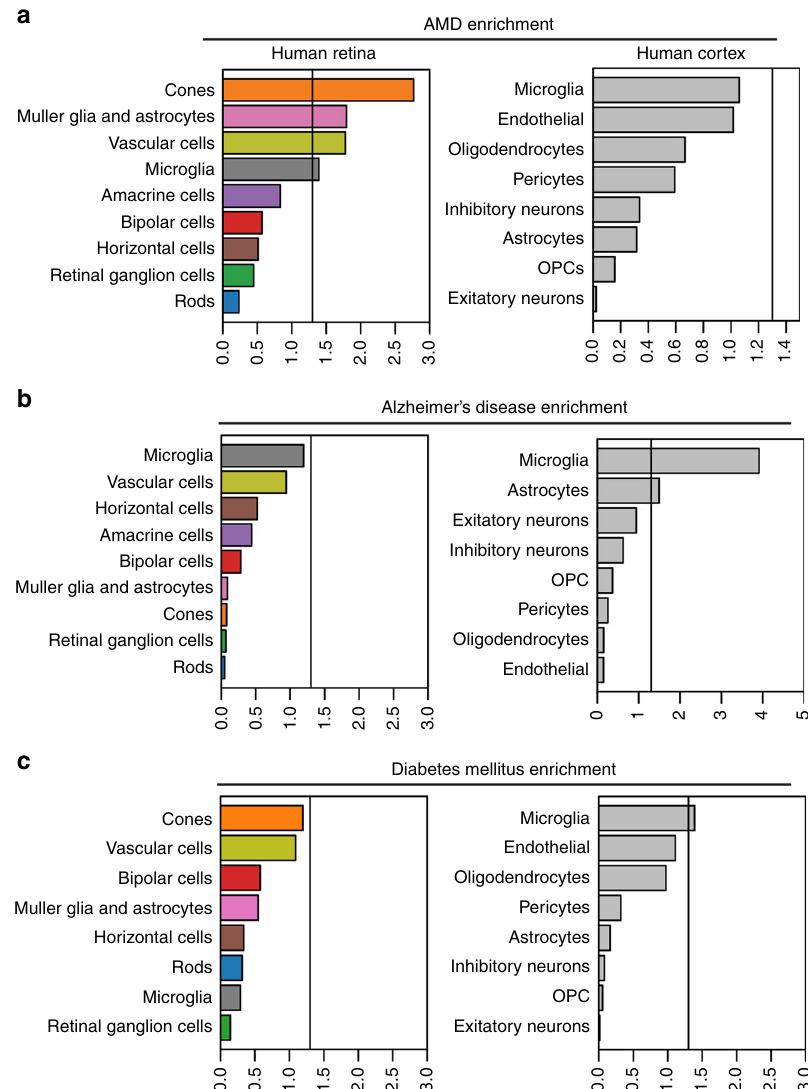
Fig. 5 Cell-type trait association analyses. Bars show the mean strength of association computed with MAGMA (-log10P) for AMD ( a ) Alzheimer ’ s Disease ( b ), and Diabetes Mellitus ( c ) using cell type preferential gene expression in either the human retina micro fl uidics scRNA-seq dataset (left) or the human cortex scRNA-seq dataset as a control (right). The vertical line indicates whether the cell-type is signi fi cantly associated with the trait ( P < 0.05, MAGMA gene-set analysis test,